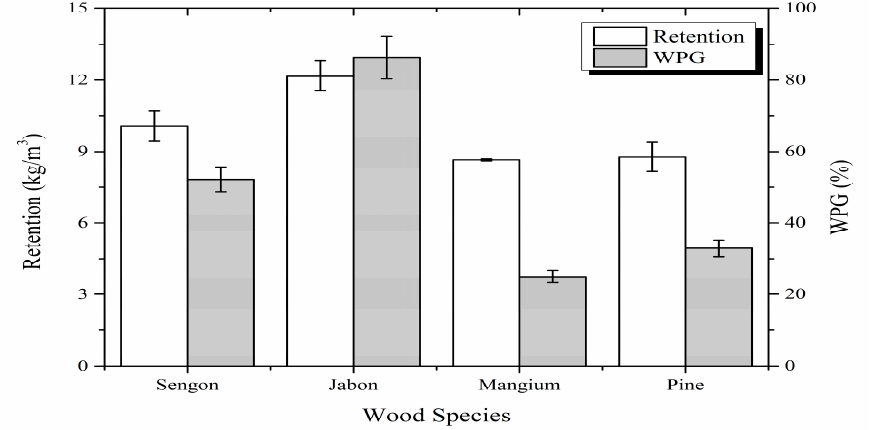
Figure 4. Retention and WPG of each species according to treatment.